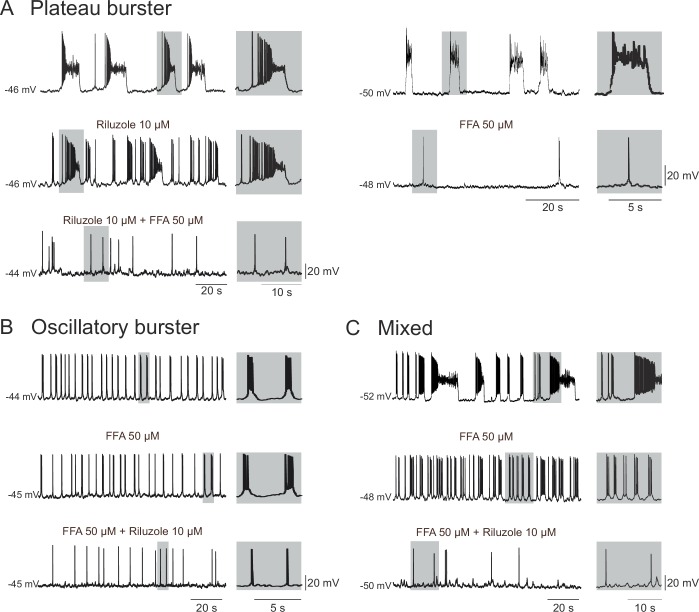
Membrane conductances underlying the different discharge patterns.Patch-clamp recordings of plateau (A), oscillatory (B) and mixed (C) bursting pacemaker neurons in control conditions (top traces), in the presence of either 10 µM Ril or 50 µM FFA (middle traces) or in the presence of 10 µM Ril + 50 µM FFA (bottom traces). The left and right panels in A illustrate two different plateau bursters under different indicated pharmacological treatments. Rhythmic burst activity of the plateau pacemaker was mostly affected (i.e., reduced) by blockade of ICAN channels with FFA (A), whereas the oscillatory pacemaker activity was more sensitive to persistent sodium channel (INaP) blockade with Ril (B). Correspondingly, longer duration plateau driven discharge in the mixed pacemaker phenotype was blocked with FFA alone, whereas remaining short-duration oscillatory bursts were blocked by the addition of Ril (C). Shaded activity at right of each trace: recording excerpts on expanded time-scale to facilitate comparison.